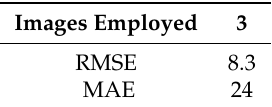
Table 4. RMSE and MAE obtained for the EoS estimation using a dynamical